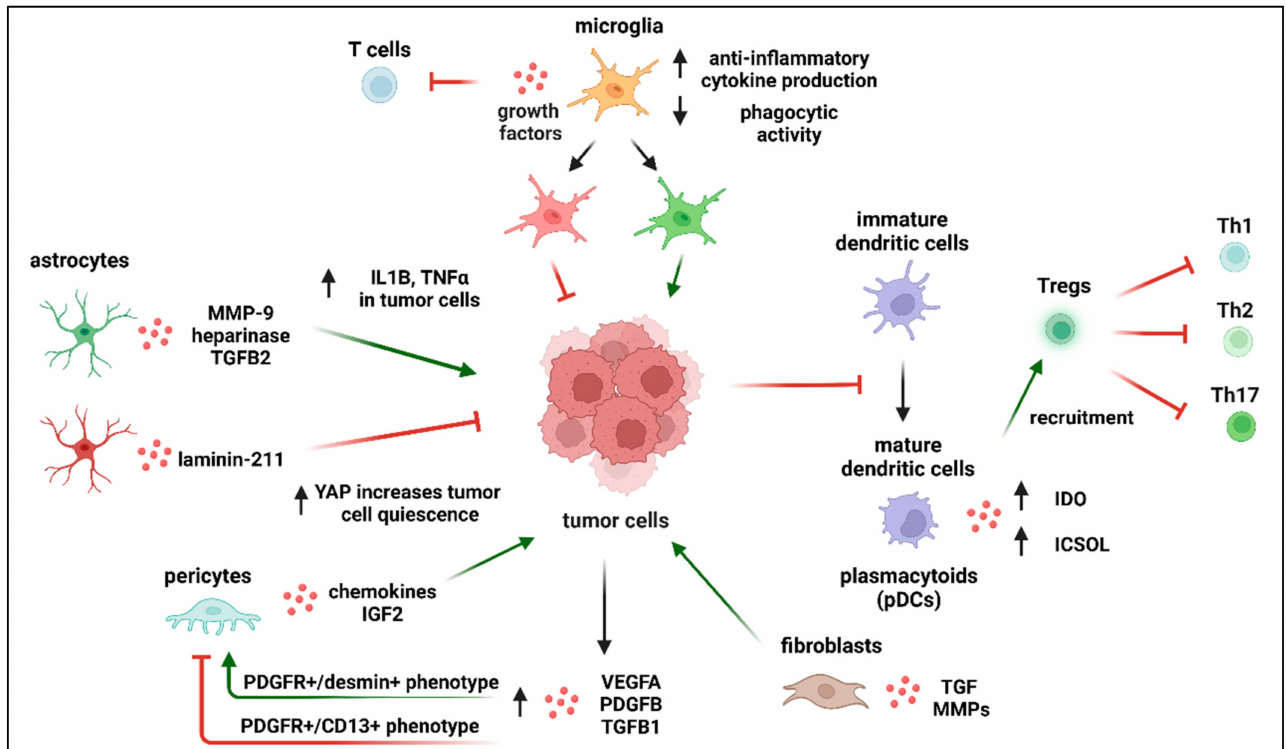
Figure 6. Metastatic cell interactions with their microenvironment. Astrocytes can inhibit the growth of cancer cells through the production of laminin 211, which increases YAP, which, in turn, increases quiescence in cancer cells. They can also support cancer growth through the production of TGF- β 2. CNS cells can produce IL1 β and TNF α , which can push the astrocytes into a vicious cycle of overactivation. Pericytes produce IGF2 and chemokines, which support cancer metastasis. Cancer cells produce VEGFA, TGF- β , and PDGFB, which selectively increase a favorable pericytes phenotype. Fibroblasts constitute critical support for cancer cell growth through the production of MMPs and tissue growth factors. Different microglia types can either inhibit or support cancer cell growth. One of the strategies microglia can use to support tumor growth is inhibiting T cells. On the same note, dendritic cells can produce IDO and ICOSL, which recruit Tregs, which, in turn, inhibit pro-inflammatory CD4+ T cells, such as Th1 and Th17. Created with